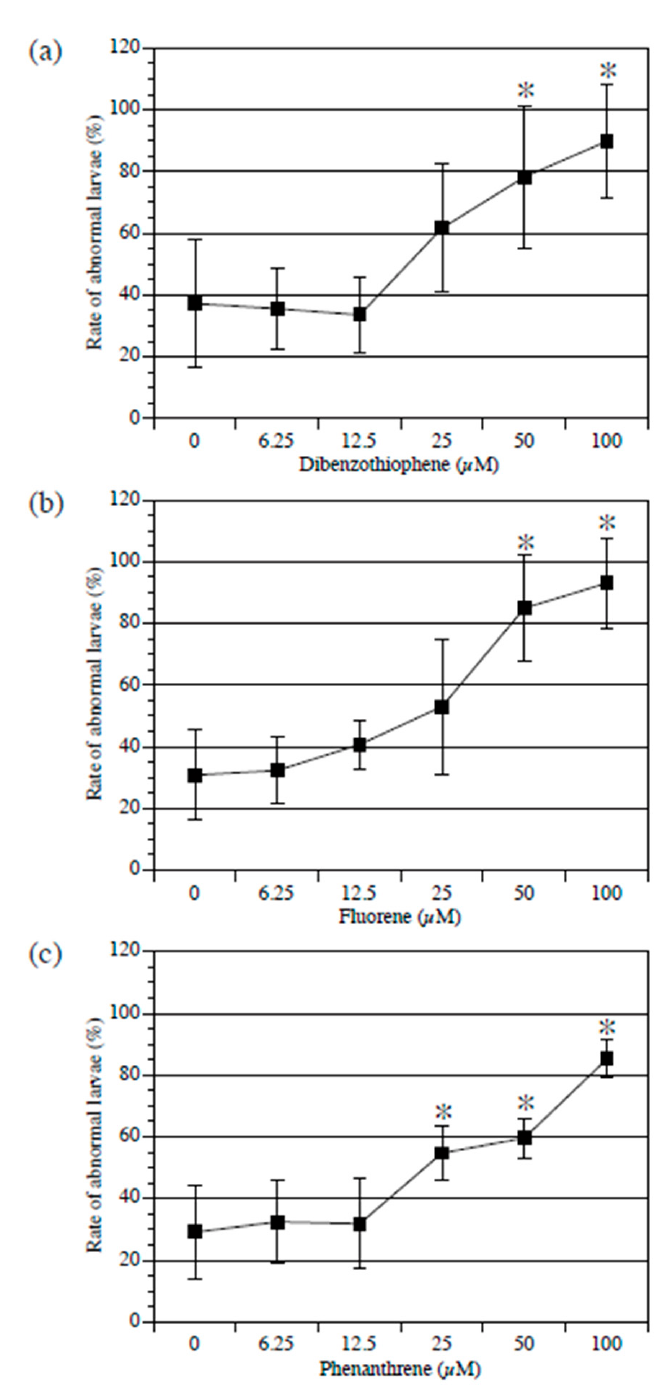
Figure 1. Effect of polycyclic aromatic hydrocarbons (PAHs) on Ciona embryogenesis. Percentage of abnormal larvae treated with different concentrations of dibenzothiophene ( a ), fluorene ( b ), and phenanthrene ( c ) from fertilized egg to swimming larva stages. Mean values of five biological replicates are presented with standard deviations. Approximately 50 embryos were examined in each experiment. Asterisks indicate significant differences ( p < 0.05; Dunnett’s test).